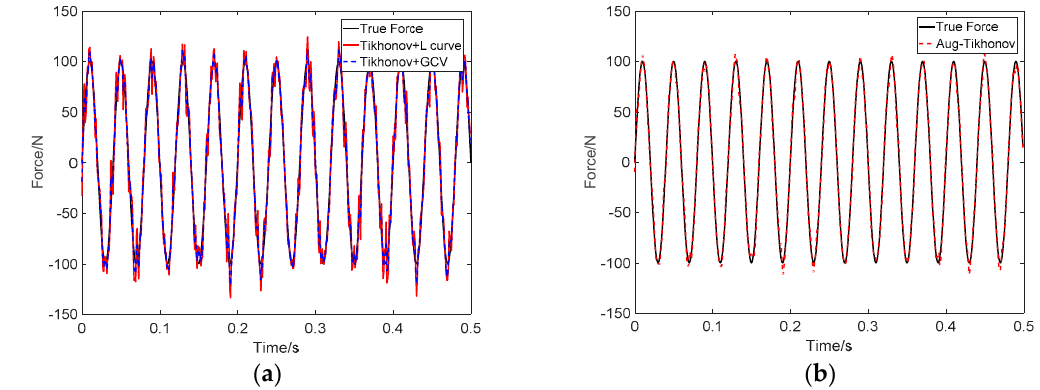
Figure 5. Identification result of sinusoidal load at SNR 40 dB: ( a ) Tikhonov method; ( b ) the proposed method.